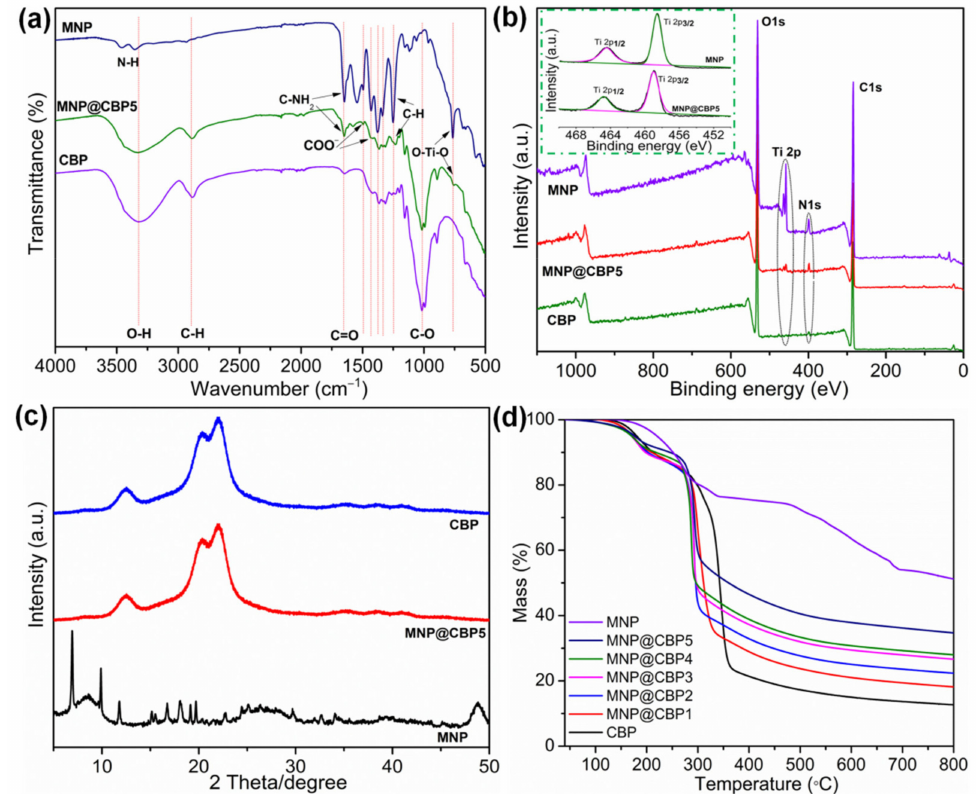
Figure 4. ( a ) FTIR spectra of CBP, MNP and MNP@CBP5 powders; ( b ) the full wide-scan XPS spectra of CBP, MNP and MNP@CBP5 powders, and the high resolutions Ti 2p spectra of MNP and MNP@CBP5 powders; ( c ) XRD patterns of CBP, MNP and MNP@CBP5 powders; ( d ) thermogravi- metric analysis of CBP, MNP and MNP@CBPs